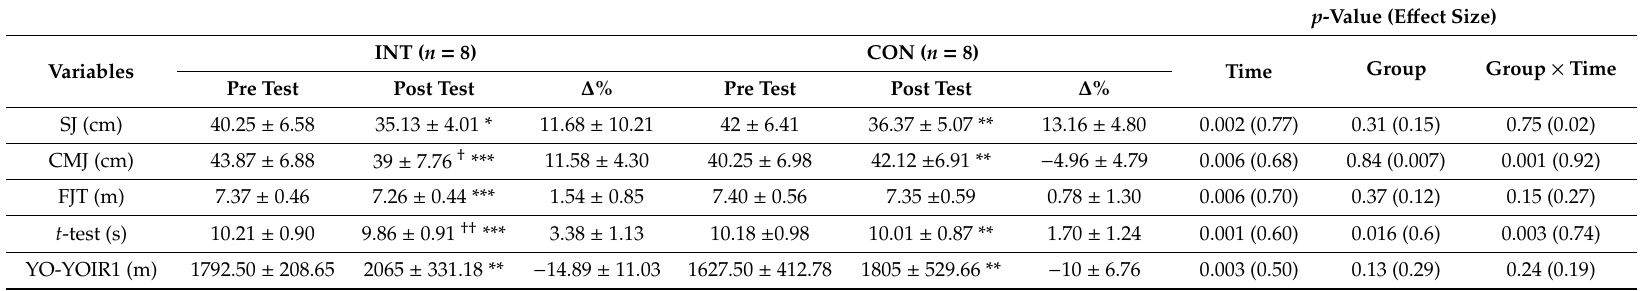
Table 3. Jump, change-of-directions and Yo-Yo intermittent recovery test level 1 performances determined before (pre-test) and after (post-test) the change-of-direction sprint training program for the intervention and the active control